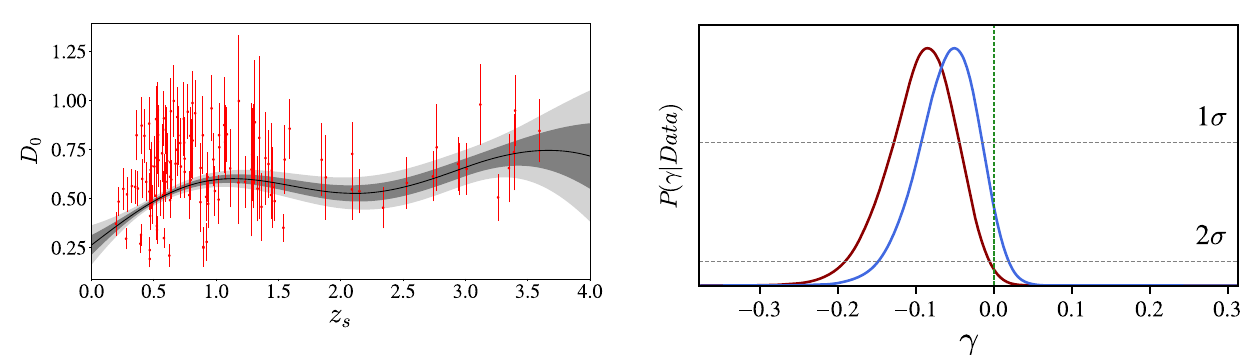
Fig. 3 The figure represent an estimate of the ratio D 0 for PLAW model. The solid black lines represent the central value reconstruction obtained by the Gaussian Process method with the corresponding 1 σ and 2 σ confidence regions